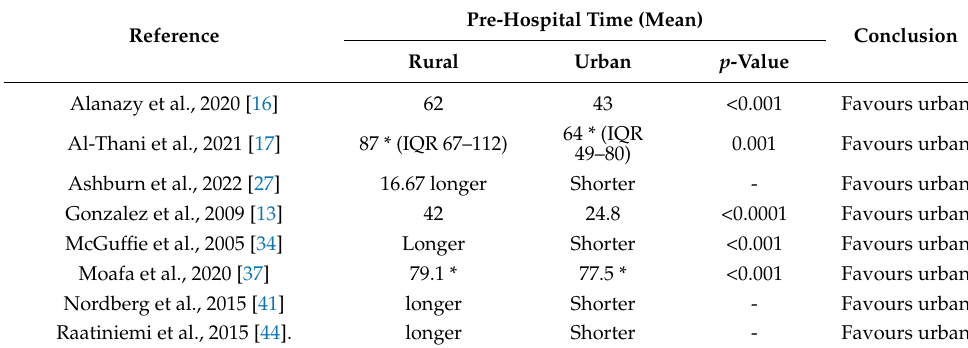
Table 5. Differences between rural and urban areas regarding pre-hospital